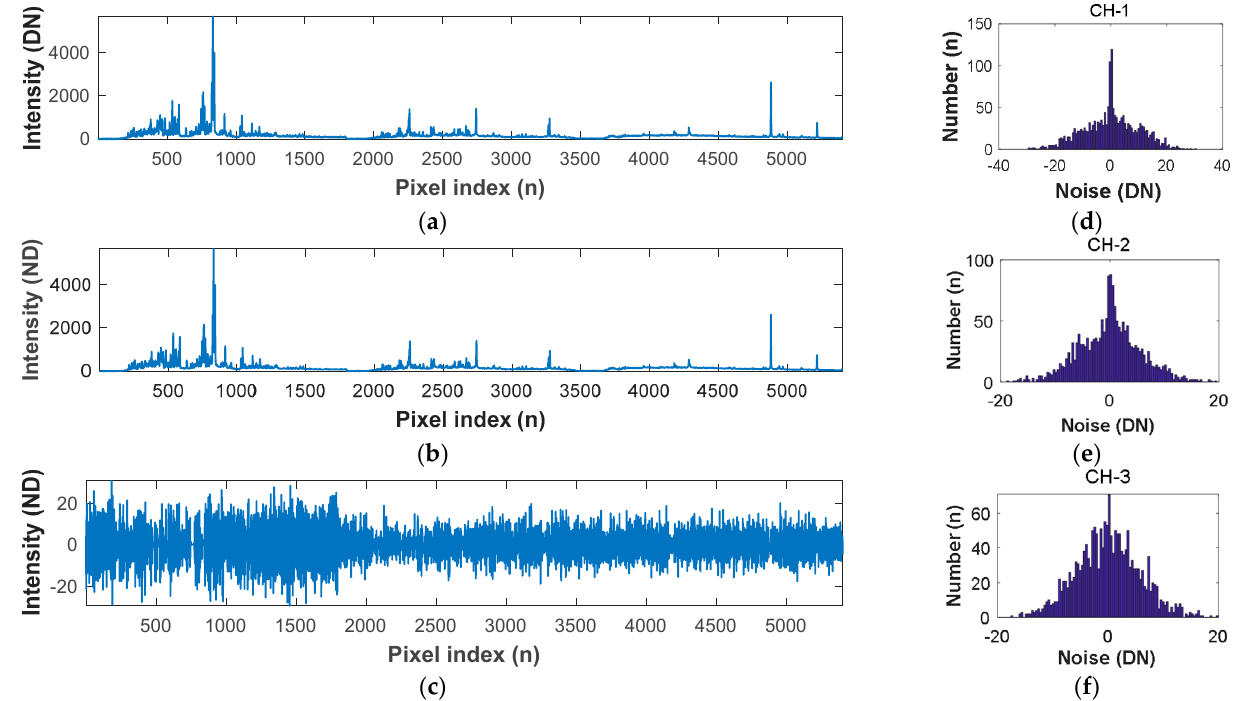
Figure 3. Denoising the white noise of one spectrum within three channels for Sample-A06: ( a ) raw spectrum; ( b ) denoised spectrum; ( c ) noise; ( d – f ) noise of three channels.